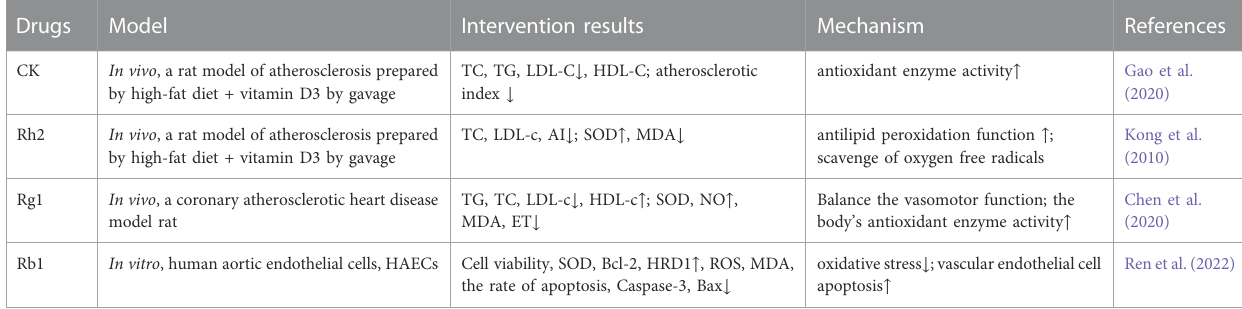
TABLE 6 Ginsenosides inhibit oxidative stress in the treatment of atherosclerosis. Drugs